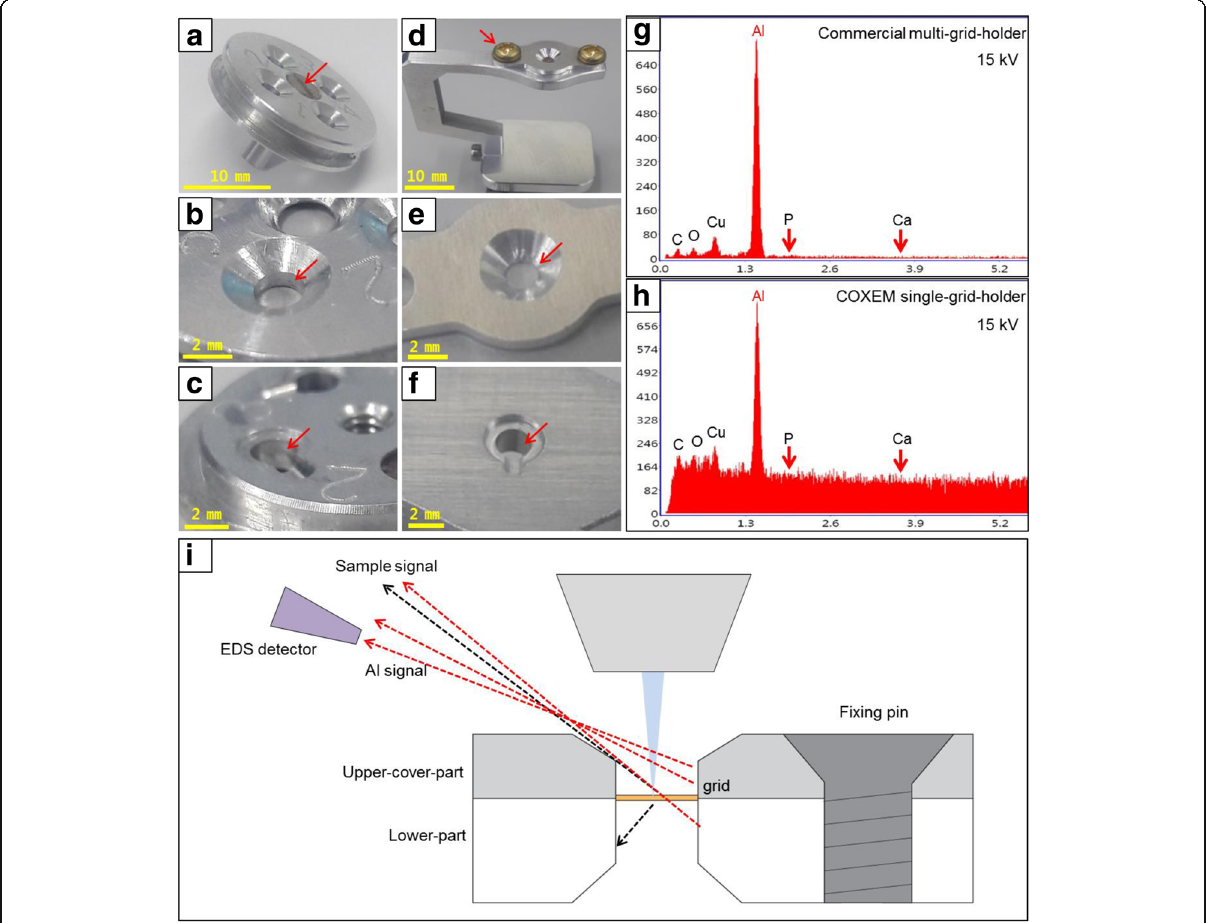
Fig. 1 a The commercial multi-grid holder which can load four TEM grids. b The thick upper cover part of a which can block EDS signals to the detector. c The thick lower part of a . d The COXEM single-grid holder for STEM-in-SEM. e The thick upper cover part of d . f The thick lower part of d . g , h The EDS spectra of the Mini-SEM obtained at 15 kV from synthetic hydroxyapatite (Ca 5 (PO 4 ) 3 OH) using the holders in a and d show high Al intensities generated from the holder. i Schematic diagram showing the source of strong Al signals and weak sample signals from